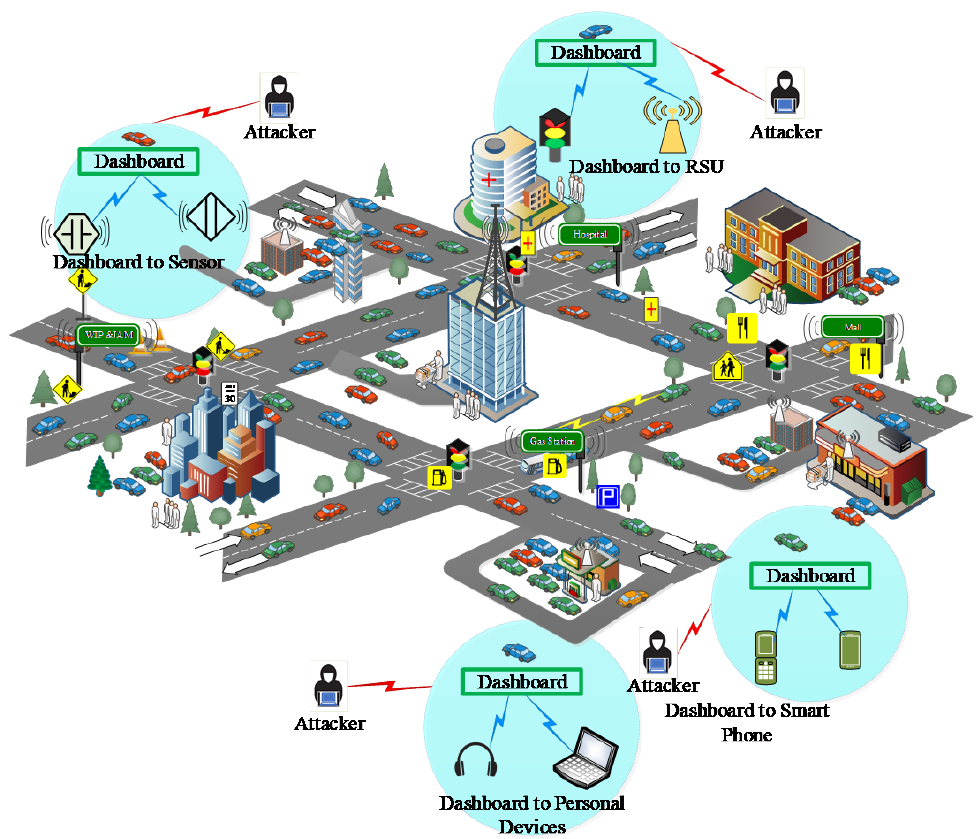
Figure 1. In-Vehicle security scenarios with possible threats.